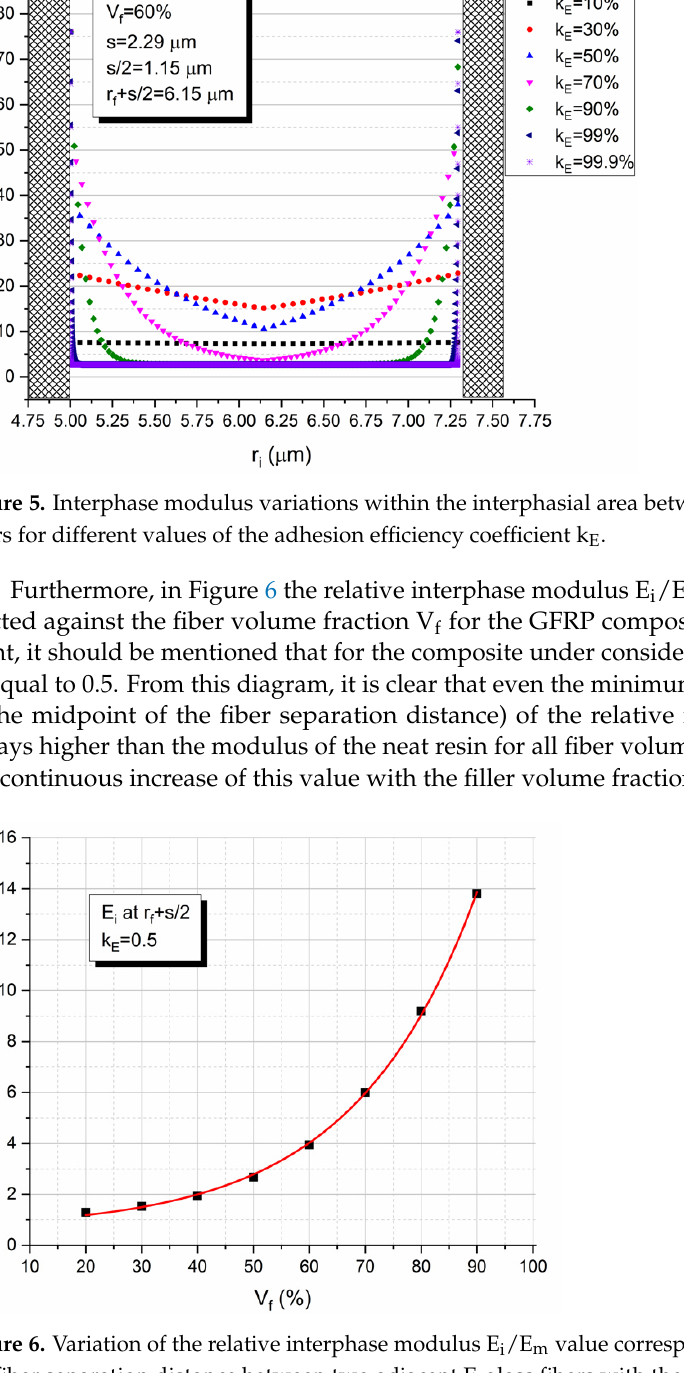
Figure 6. Variation of the relative interphase modulus E i /E m value corresponding to the midpoint of the fiber separation distance between two adjacent E-glass fibers with the fiber volume fraction.